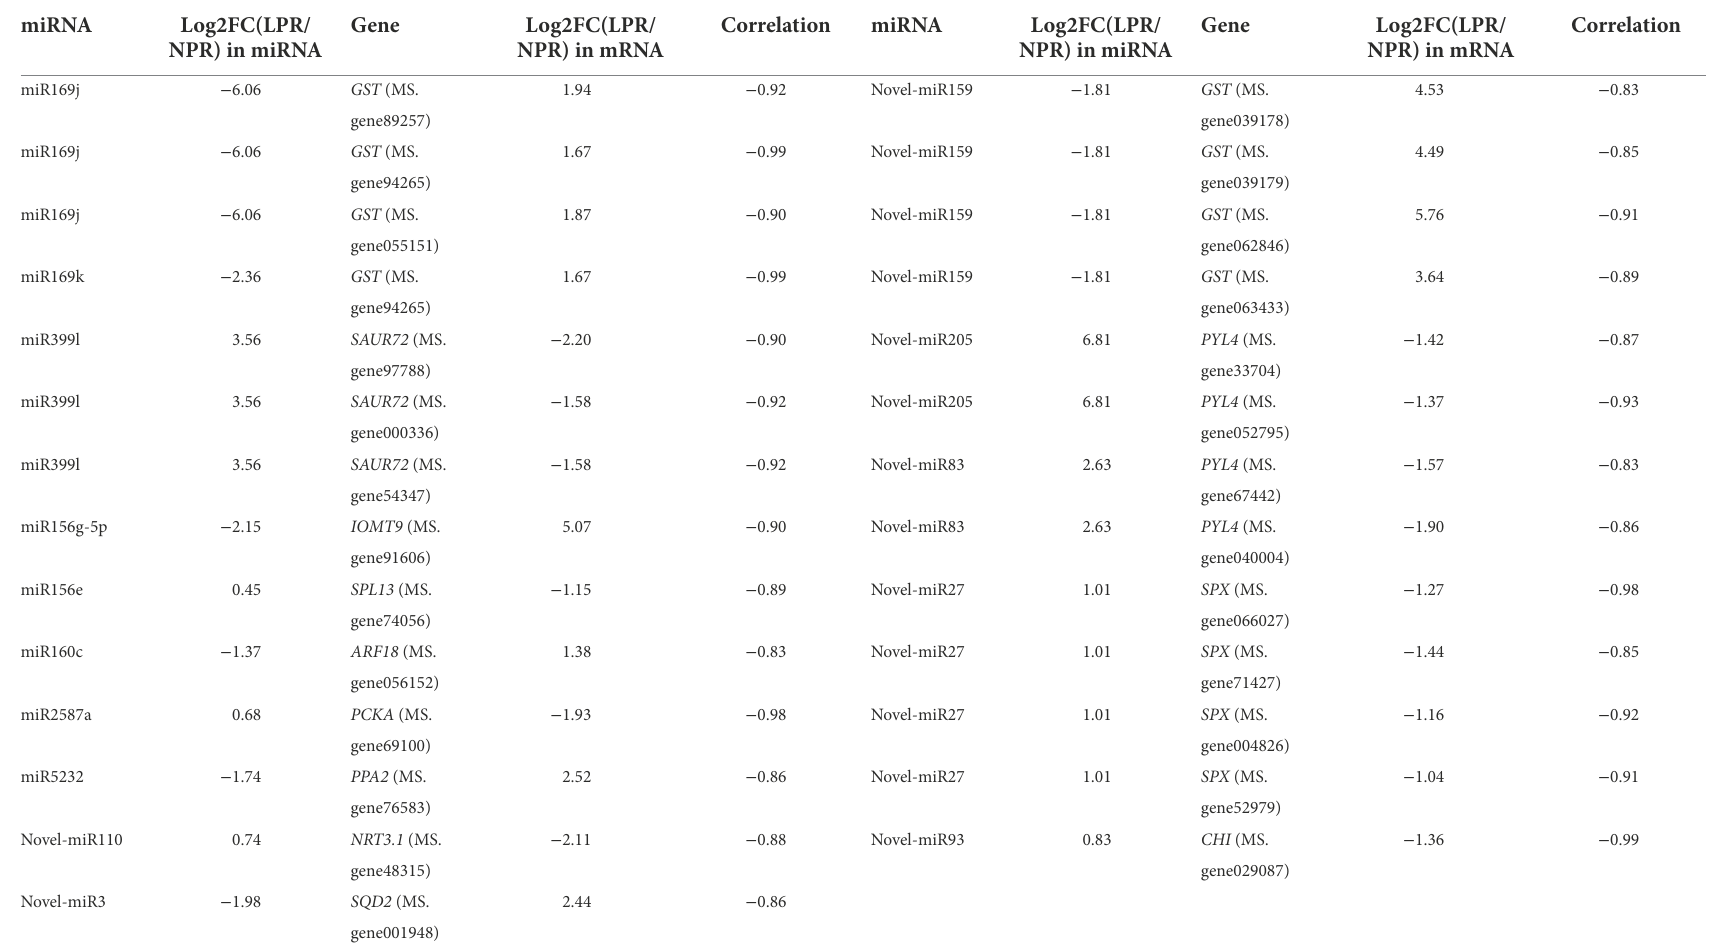
TABLE 1 The correlation of miRNA and its target mRNA. miRNA Log2FC(LPR/ Gene Log2FC(LPR/ Correlation miRNA Log2FC(LPR/ NPR) in miRNA NPR) in mRNA